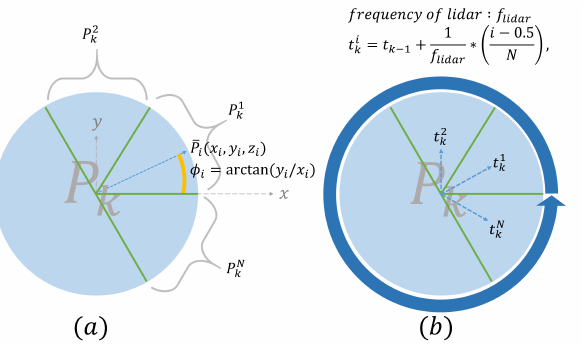
Figure 4. ( a ) Each subframe of P k is defined as P i i ∈ { 1, ..., N }